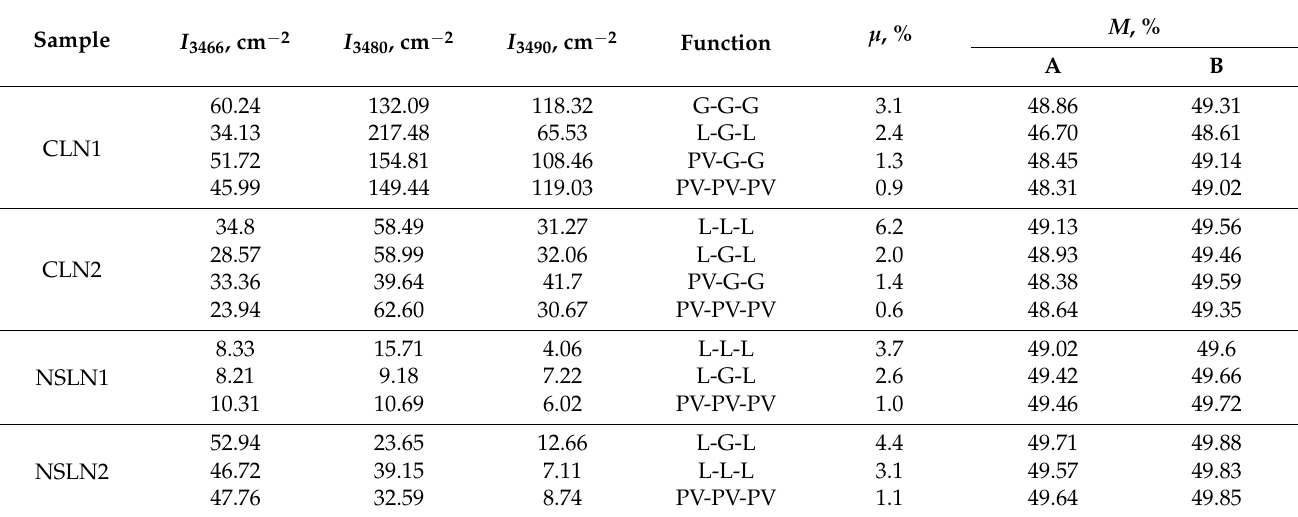
Table 3. The IR spectra parameters of the studied LN crystals and the results of calculating